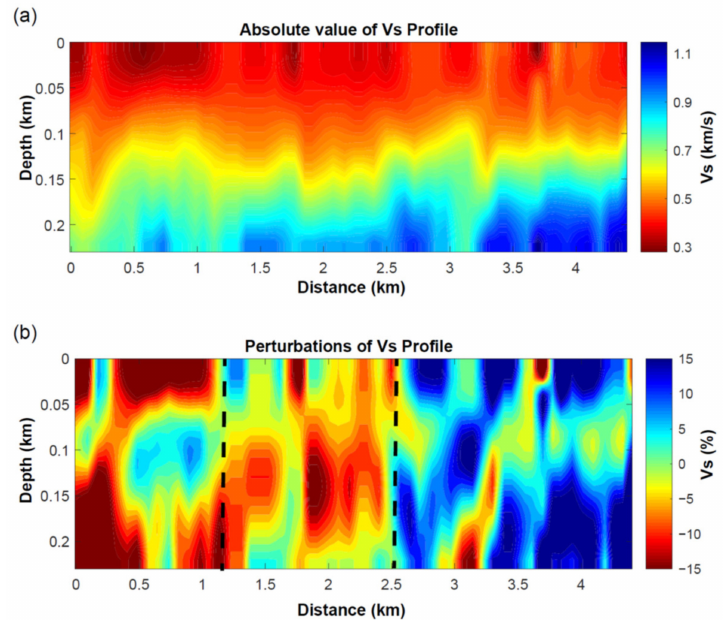
Figure 7. ( a ) Cross-section of the shear velocities across the Meishan Fault. ( b ) Perturbations of the Vs profile, and perturbations relative to the average shear velocity at each